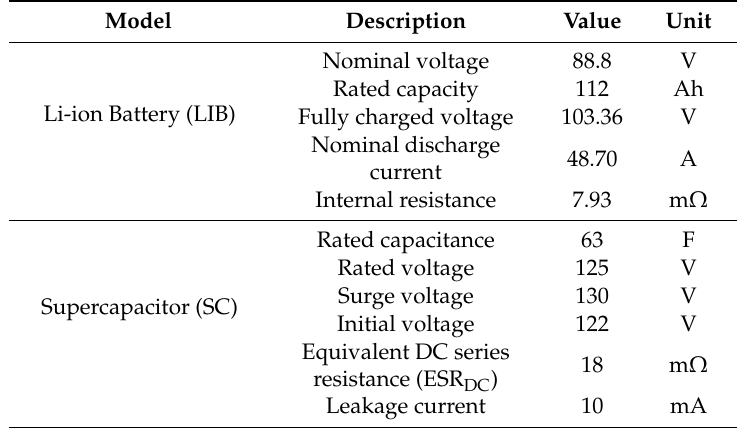
Figure 7. Simulation models of the proposed energy storage systems (ESSs). Table 11. Applied parameters of LIB and SC modules for the simulation.